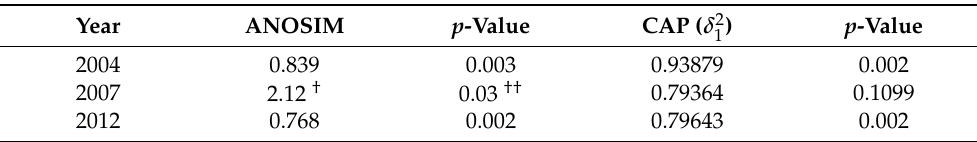
Table 4. Summary of results from the statistical comparison of southern versus northern GoM species assemblage similarities (ANOSIM) and the relationship of species assemblage similarity with latitude